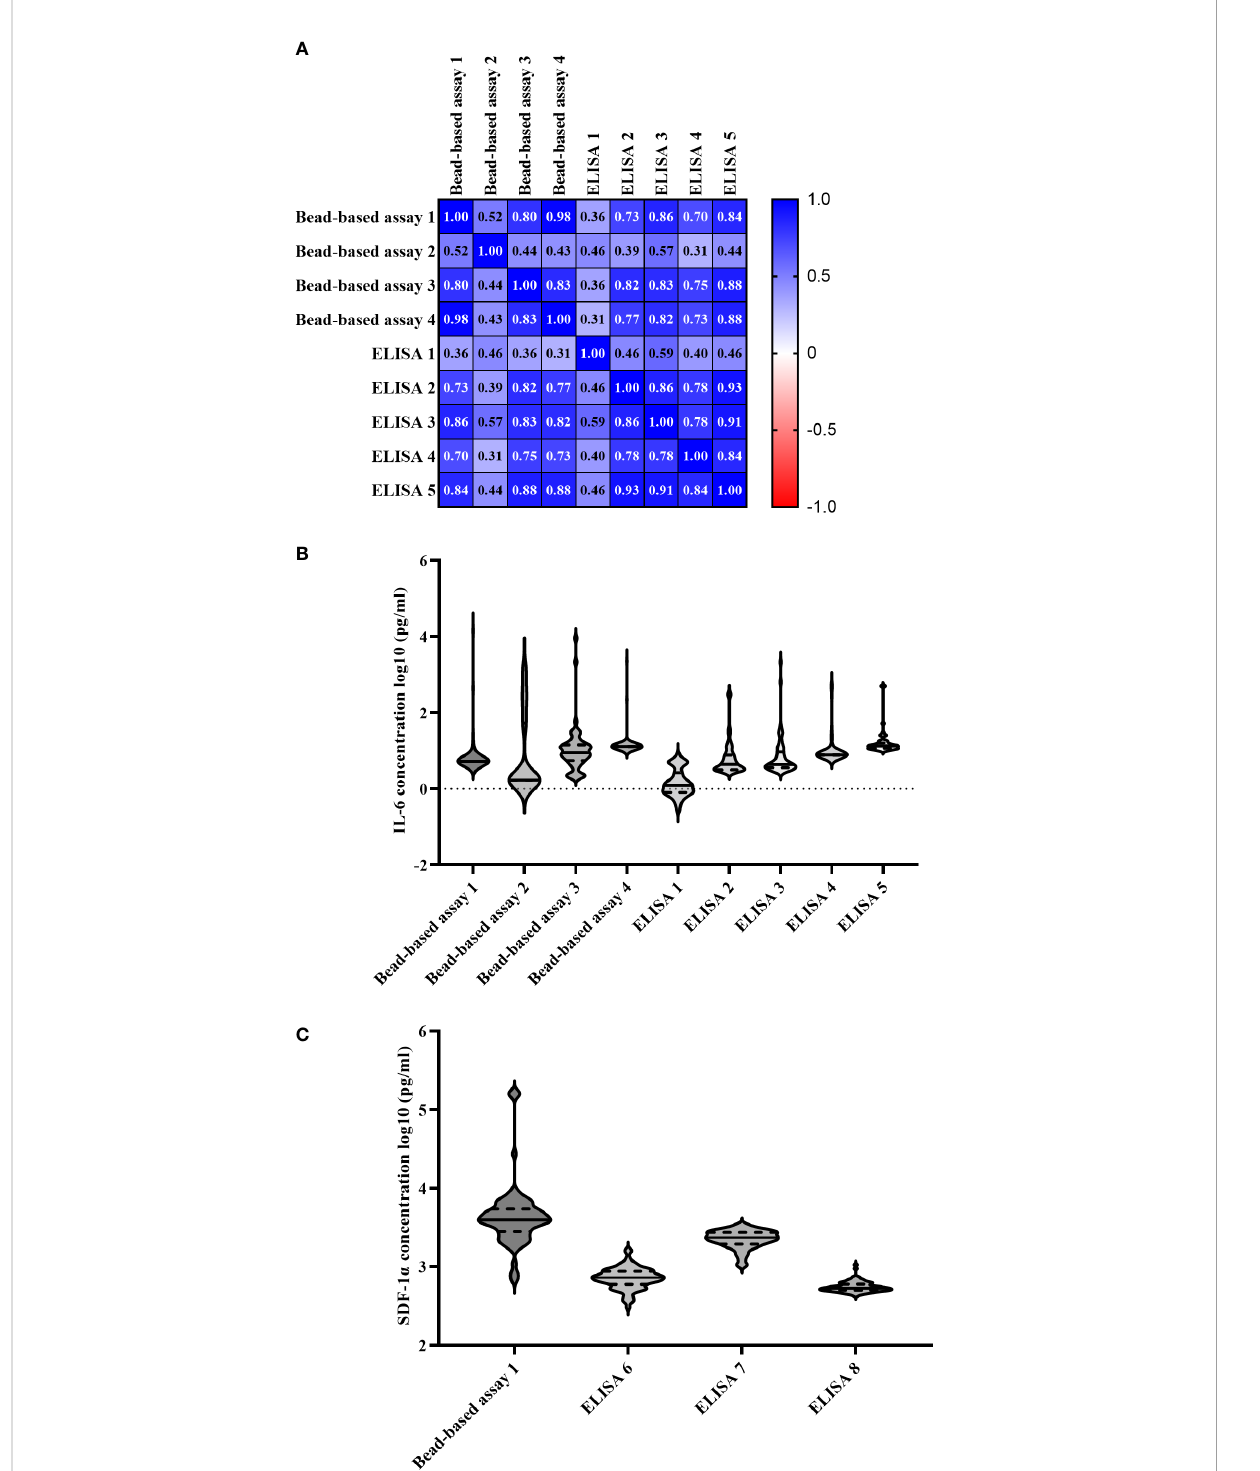
FIGURE 5 Comparability of multiple bead-based assays and ELISAs measuring IL-6 and SDF-1 a levels. (A) Pearson correlation matrix of different IL-6 measuring bead-based assays using 50 randomly selected samples. (B) IL-6 levels (log10-transformed, pg/ml) of individual samples measured on all assays. The black horizontal lines represent the median concentrations with quartiles labeled as dashed lines. (C) SDF-1 a levels (log10- transformed, pg/ml) of individual samples measured on all assays. The black horizontal lines represent the median concentrations with quartiles labeled as dashed lines. IL, interleukin; MOGAD, myelin oligodendrocyte glycoprotein associated disease; MS, multiple sclerosis; NMOSD, neuromyelitis optica spectrum disorder; SDF, stromal cell-derived